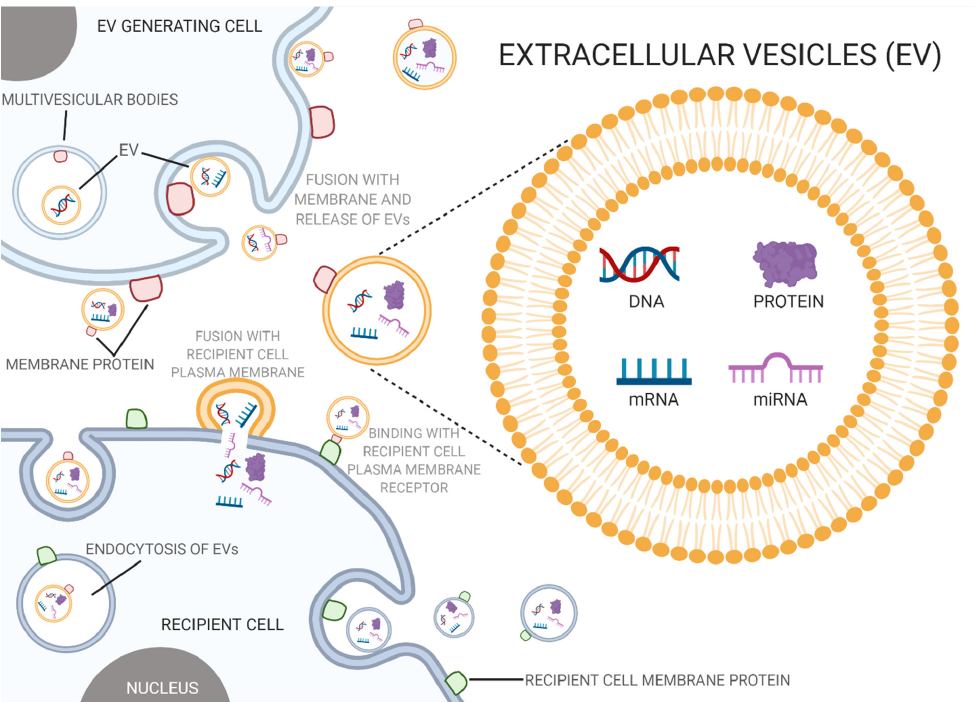
Figure 1. Extracellular vesicles and prenatal alcohol exposure (PAE). Extracellular vesicles act as a mode of intercellular communication, where PAE can alter the composition and content of these vesicles which in turn has been known to disturb normal biological processes and potentially contribute to PAE’s toxic and teratogenic effects (created with BioRender.com; accessed on 7 July 2021).